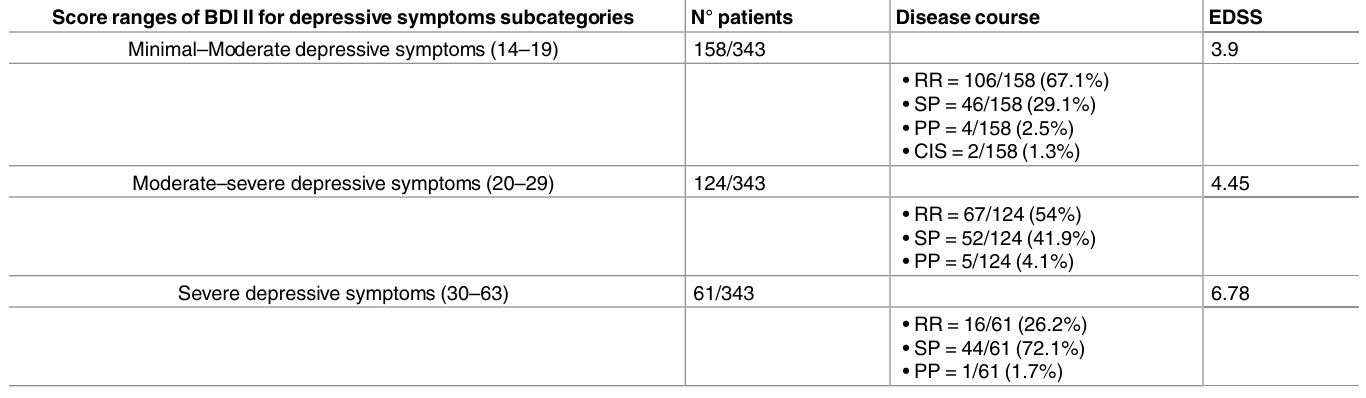
Table 3. Score rangesof BDI II according to disease course. Score rangesof BDI II for depressive symptoms